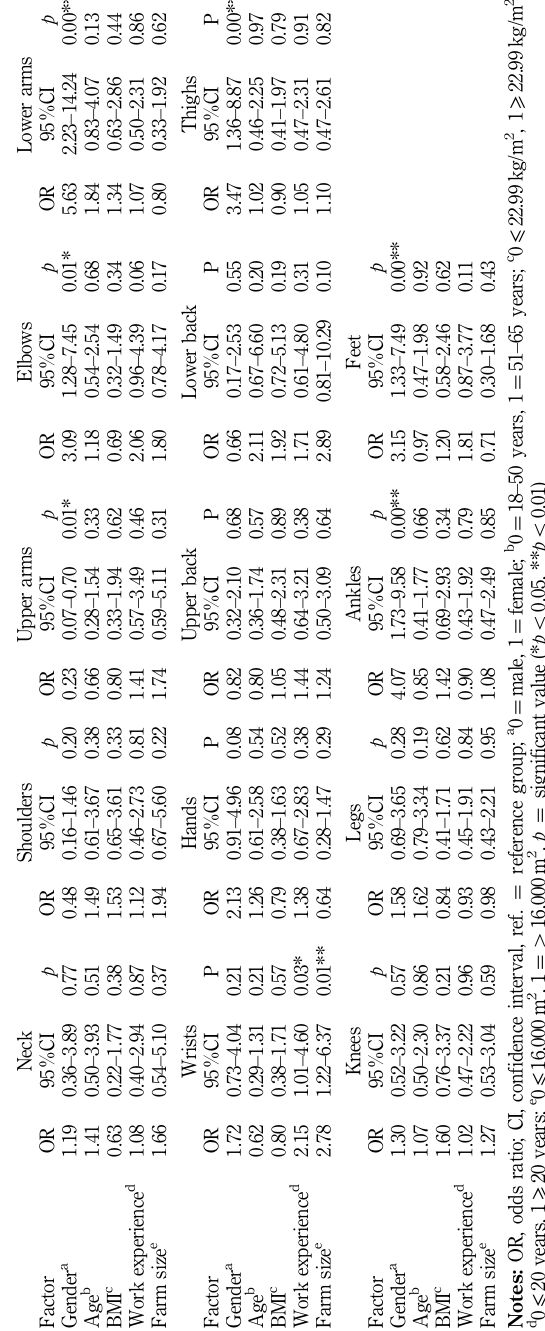
Table III. Association between factors and musculoskeletal disorders; multivariate analysis by binary logistic